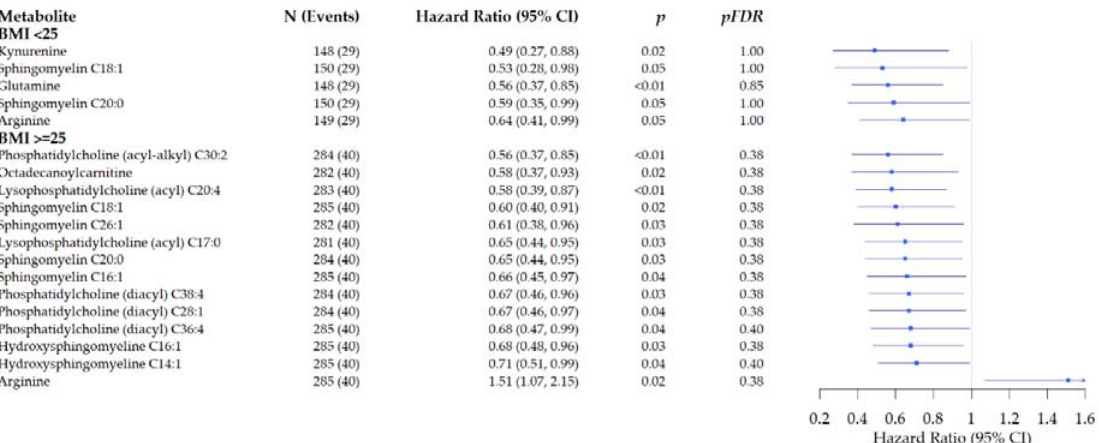
Figure 5. Forest plots of the associations of pre ‐ surgery metabolite concentrations with risk of recurrence stratified by tumor stage in prospectively followed colorectal cancer patients. Analysis are adjusted for age, sex, tumor site, BMI (kg/m 2 ) , and study cohort. (Hazard ratio and 95% Confidence Interval).